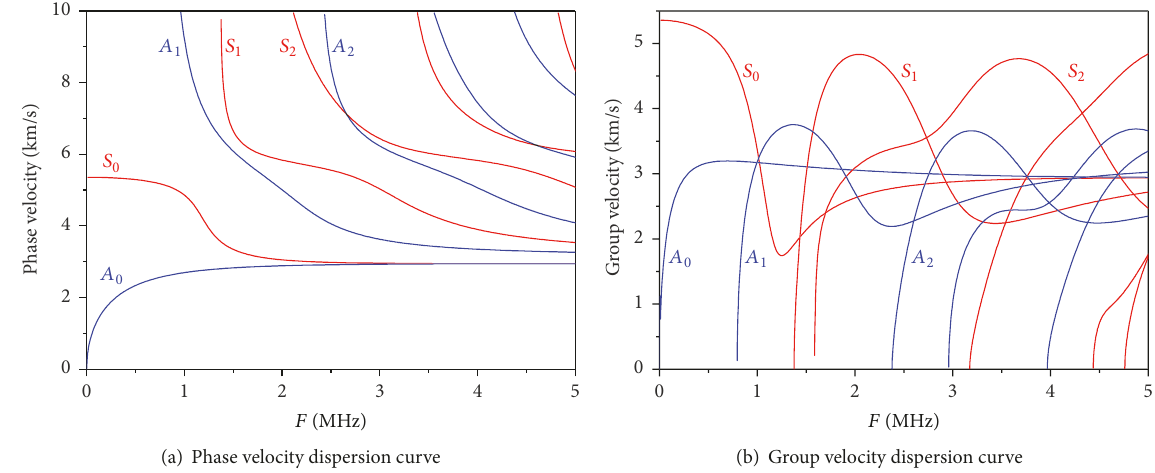
Figure 5: Dispersion curve of the Lamb wave in the KMN-I